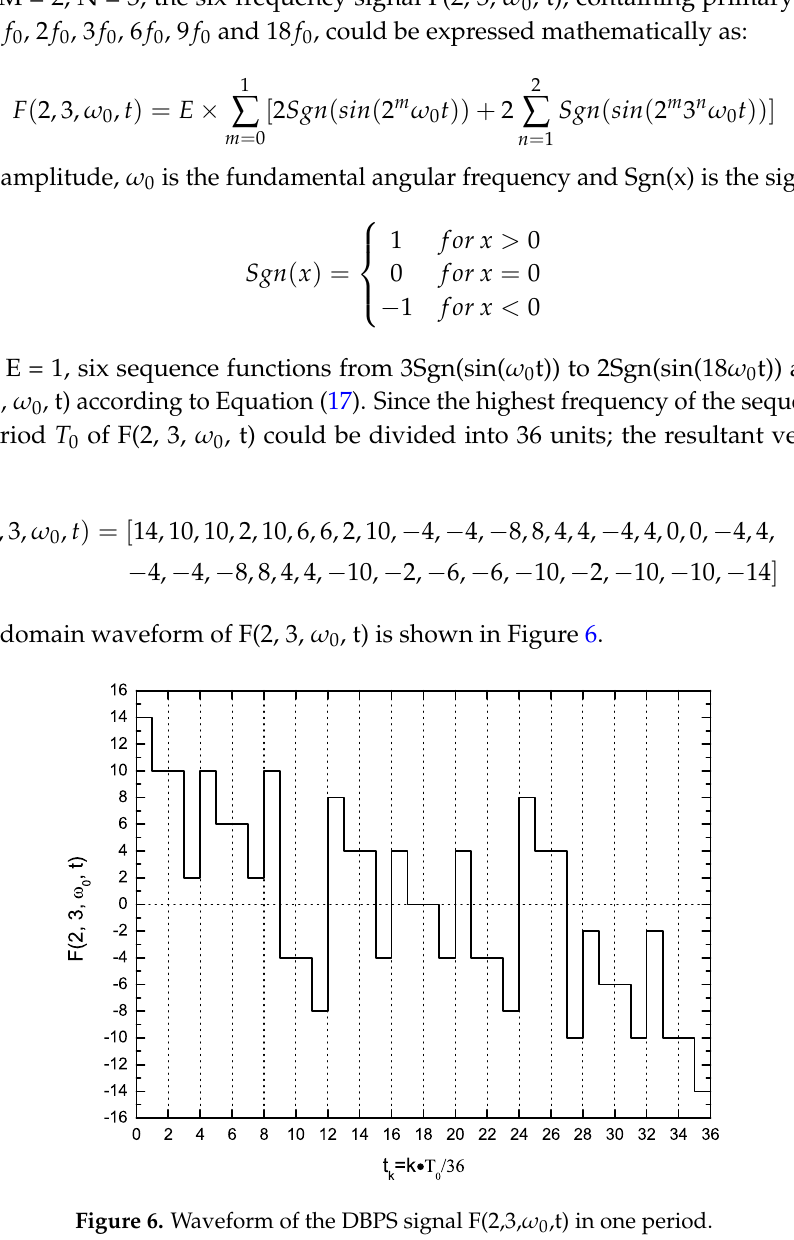
Figure 6. Waveform of the DBPS signal F(2,3, ω 0 ,t) in one